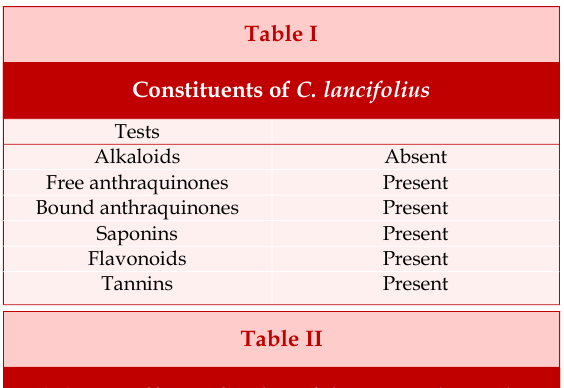
Inhibitory effects of C. lancifolius on α - glucosidase